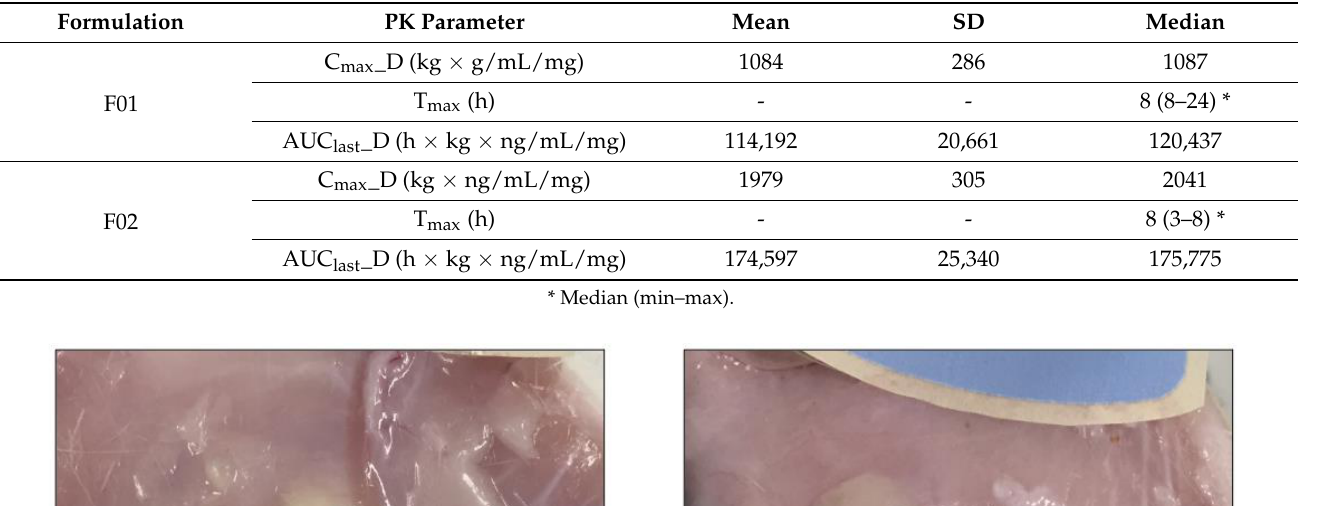
Figure 6. Meloxicam plasmatic concentration in rats following the administration of an (m)PEG–PTMC-based suspension formulation with either a triblock or a diblock copolymer. Table 3. PK parameters obtained from F01 and F02 formulations.